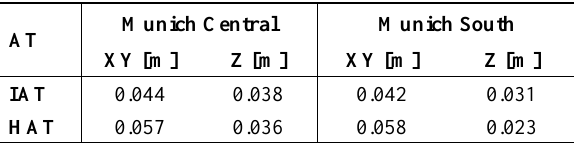
Table 12. Check point residuals